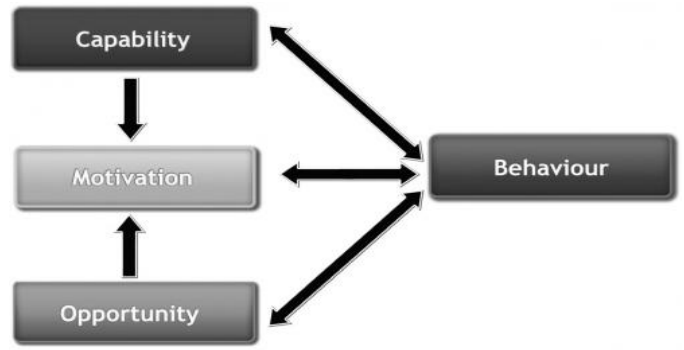
Figure 1. The COM-B Model (Michie, van Stralen & West, 2011) [20].